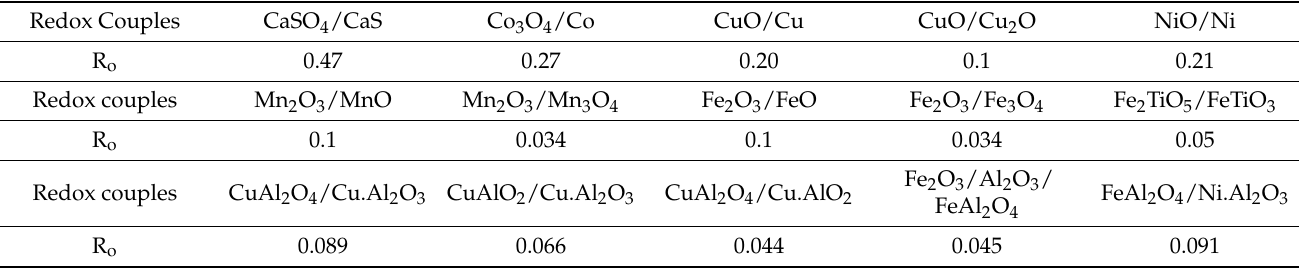
Table 2. Oxygen transport capacity of some Redox couples, R O